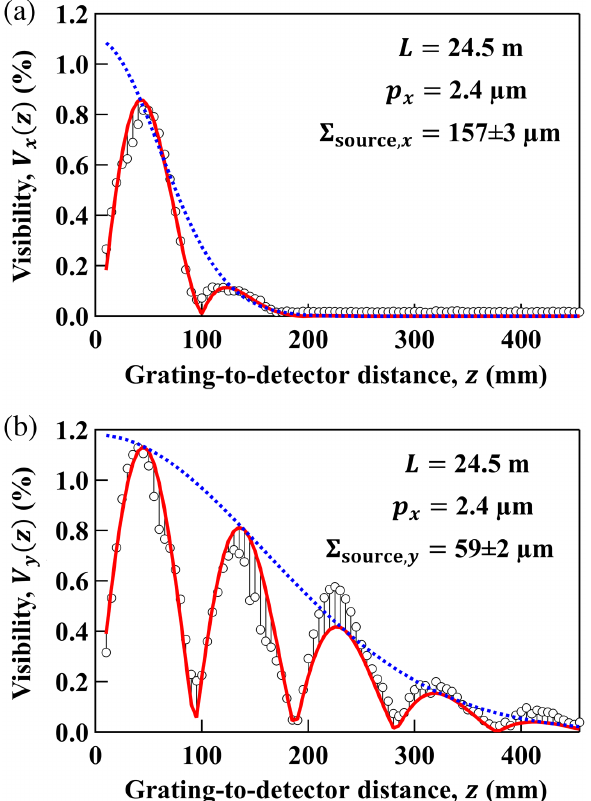
FIG. 5. Measured interferogram visibility (circles) as a function of the grating-to-detector distance in the horizontal (a) and vertical (b) directions. The solid curves are the fitted visibility curve using Eq. (3) with the listed parameters. The dotted curves are the fitted Gaussian coherence function [i.e., the exponential term in Eq. (3)], which forms the envelope function of the visibility curves. Note that in (b), the second peak is lower, and the third peak is higher than the fitting, which contributes mainly to the fitting error. This was due to the slight deviation (2%) of the grating duty cycle as confirmed by simulation previously